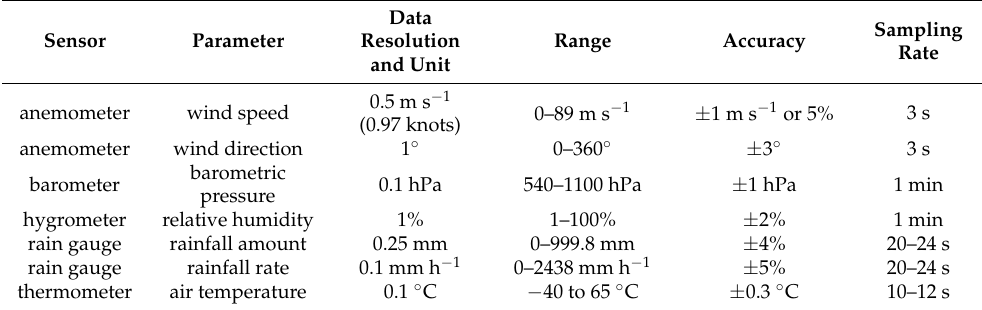
Table 3. Technical specifications of the sensors of the CNR-ISMAR meteorological station-model DAVIS Vantage